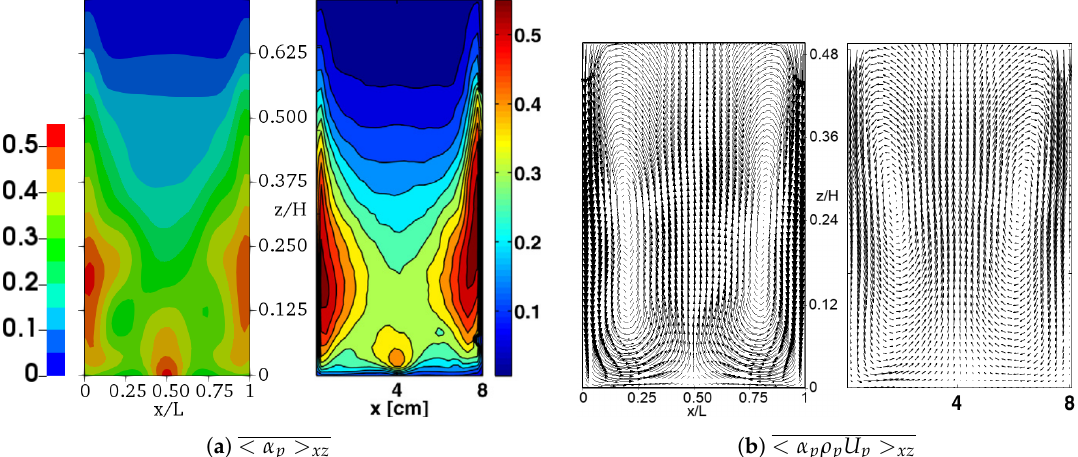
Figure 21. Numerical ( a ) againt experimental ( b ) time-averaged fields of the volume fraction and the mass flux of the solid phase. Re p = 90 and bed weight 125 g. In the simulation, µ w = µ p =